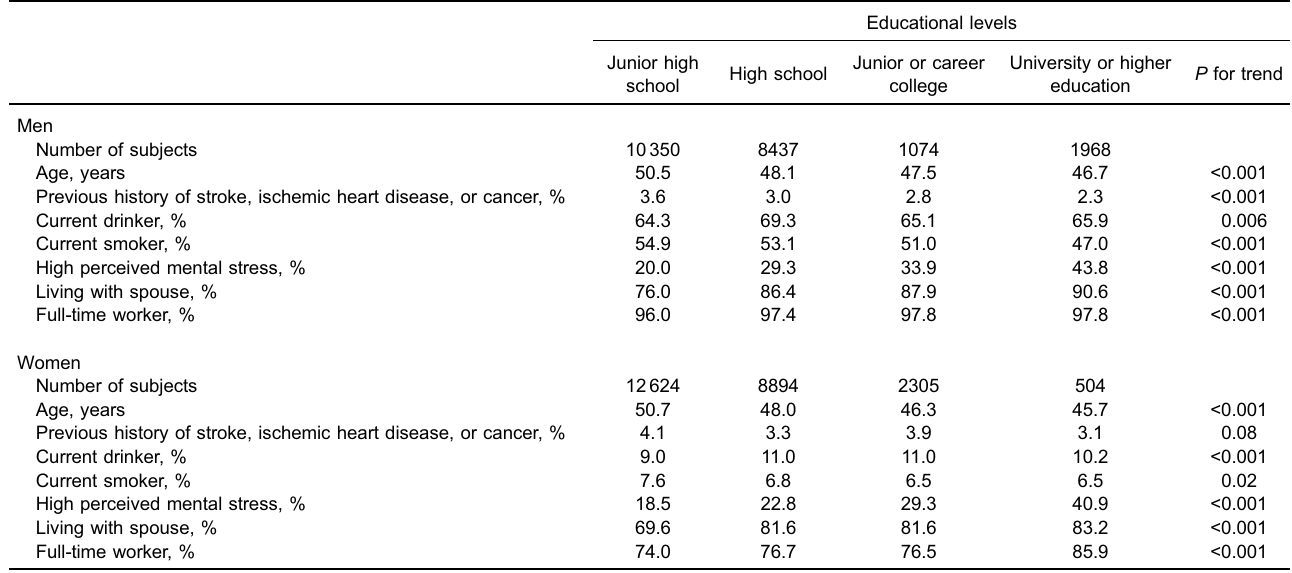
Table 1. Distributions of baseline characteristics according to educational